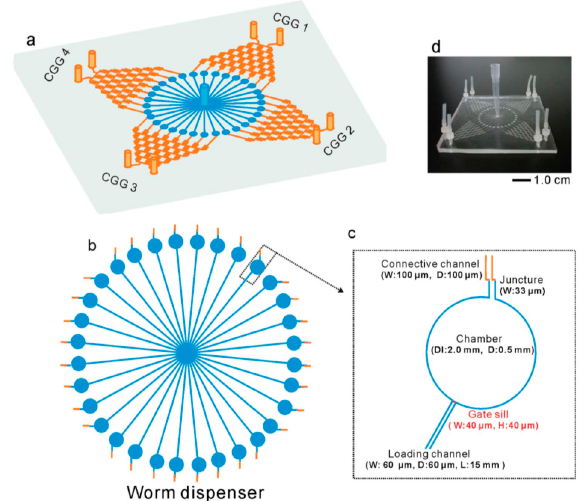
Figure 9. ( a – c ) Pictorial representations of the worm chip designed by Yang et al. [62] for drug screening. CGG 1 to 4 represent the concentration gradient generators, which generate different concentrations of drugs and whose channels connect to a chamber that radiates from a central reservoir, along with its dimensions; ( d ) the fabricated microfluidic worm chip. Reprinted with permission from the Royal Society of Chemistry.